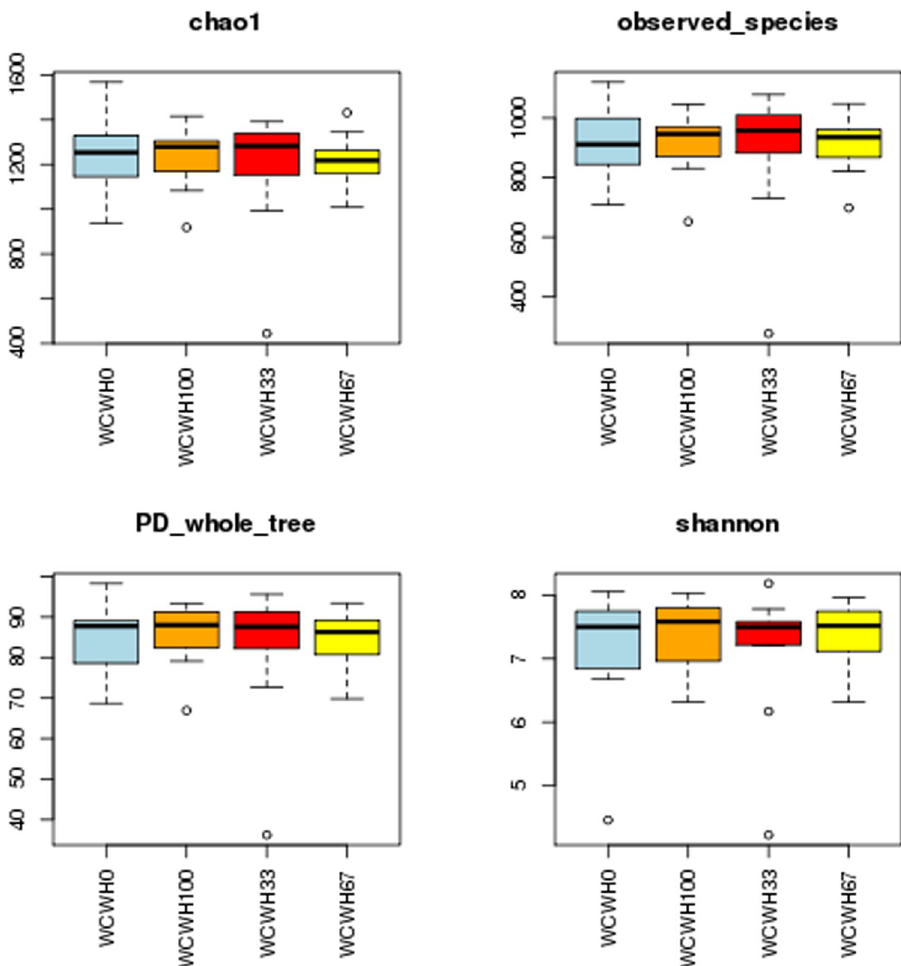
Figure 1. Richness estimates and diversity indices for bacteria within each diet group. The top and bottom boundaries of each box represent the 75th and 25th quartile values, respectively. The horizontal lines inside each box represent the median values.